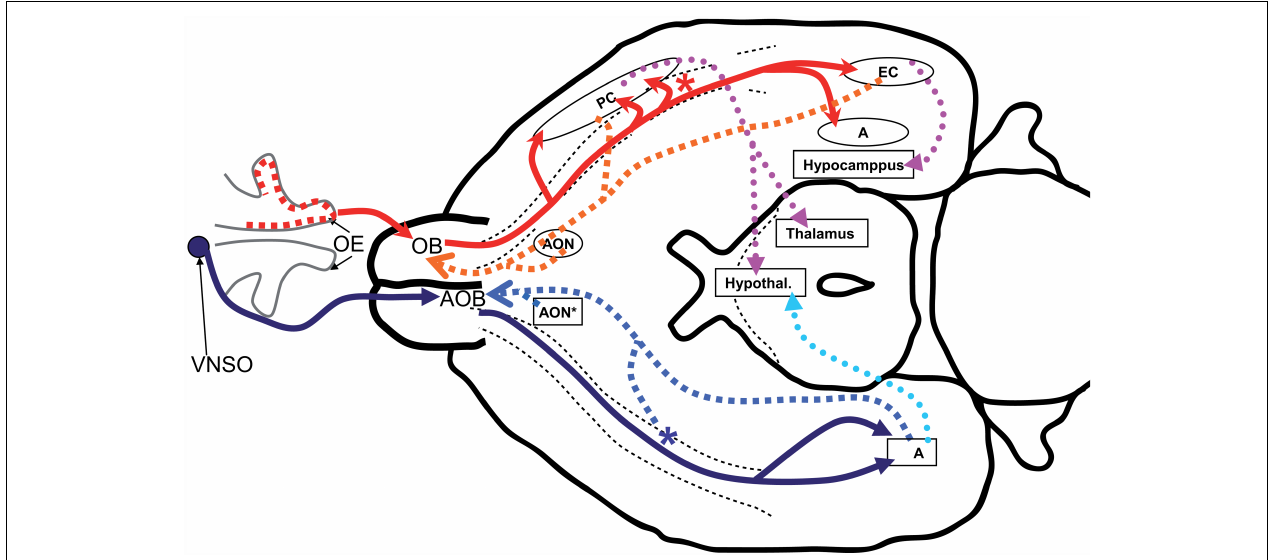
FIGURE 1 | General scheme of the connections of the olfactory system and the accessory olfactory system. The axons from the OSNs (red dots within the olfactory epithelium, EO) project to the olfactory bulb (OB), forming the olfactory nerve. The projection neurons from the OB send their axons (the lateral olfactory tract, LOT) to the different structures of the olfactory cortex, among them the anterior olfactory nucleus (AON), the taenia tecta, the olfactory tubercule, the piriform cortex (PC), the amygdaline complex (A) and the entorhinal cortex (EC), and the nucleus of the lateral olfactory tract (nLOT; red asterisk). In both cases, the olfactory nerve and the LOT are represented with gross red curved arrows. Neurons from the olfactory cortex and the nLOT project back to the OB (gross orange curved arrows). Main intracortical connections (violet dotted arrows) are